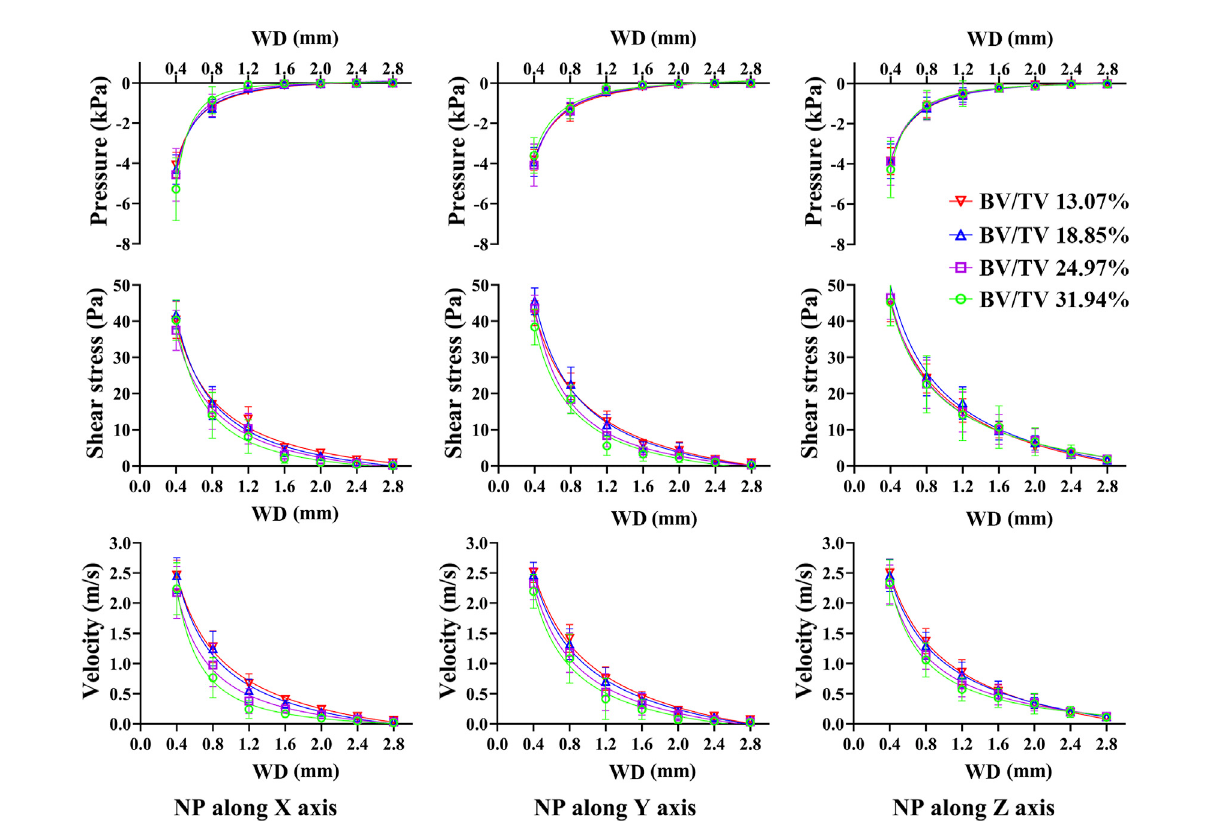
FIGURE 7 Non-linear regression curves between dependent variables and WD under different structure remodeling levels. The pressure, shear stress on trabeculaeandmarrow fl uidvelocitydecreaseexponentiallywithanincreaseinWD.Asboneremodeling,thepressure,shearstressontrabeculaeandthe morrow fl ow velocity decrease signi fi cantly only with a short